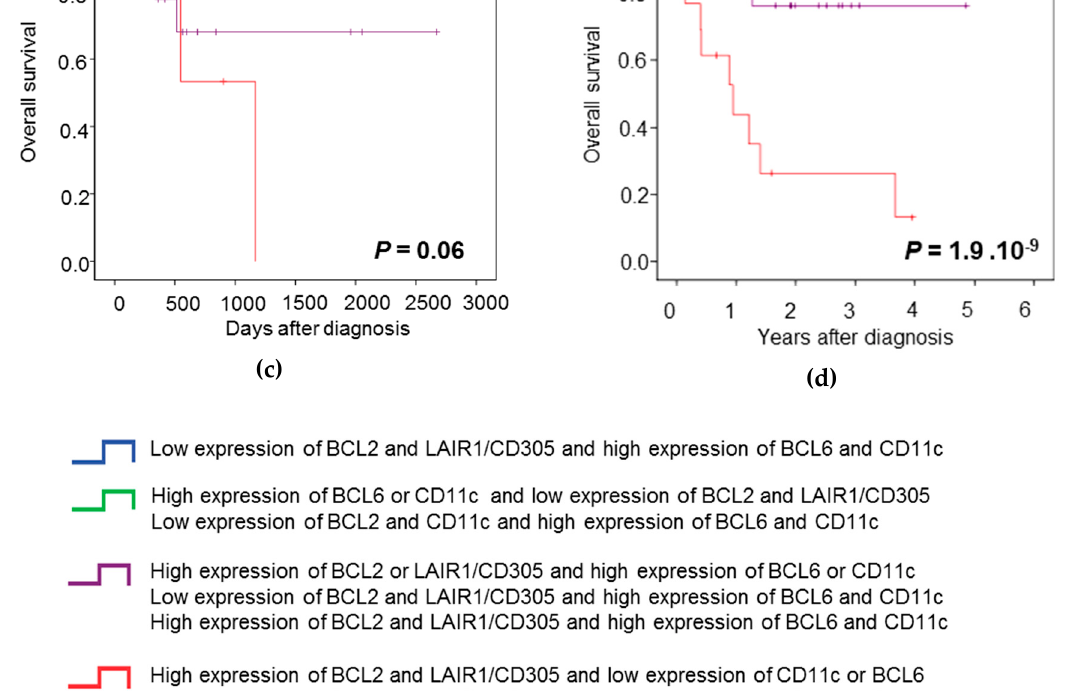
Figure 4. The risk score predicts the outcome of patients with DLBCL in four independent cohorts. Kaplan-Meier curves of overall survival in function of time in the R-CHOP Lenz cohort ( a ), CHOP Lenz cohort ( b ), R-CHOP Melnick cohort ( c ), and FFPE RCHOP cohort ( d ). Data were compared with the log rank